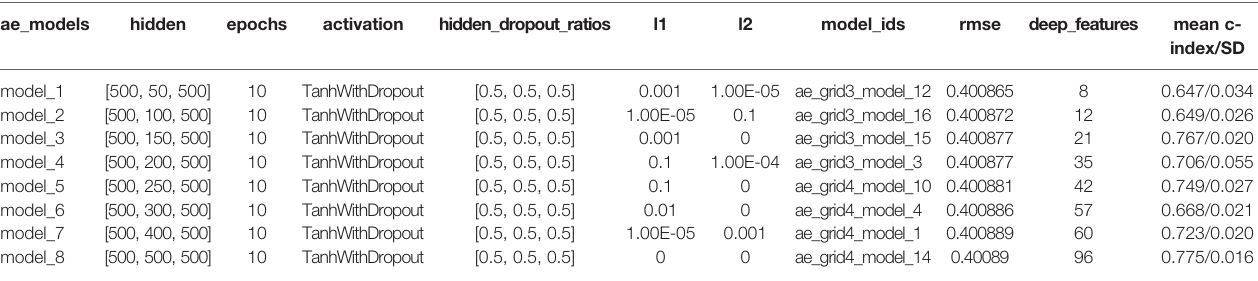
TABLE 1 | Characteristics of eight DL